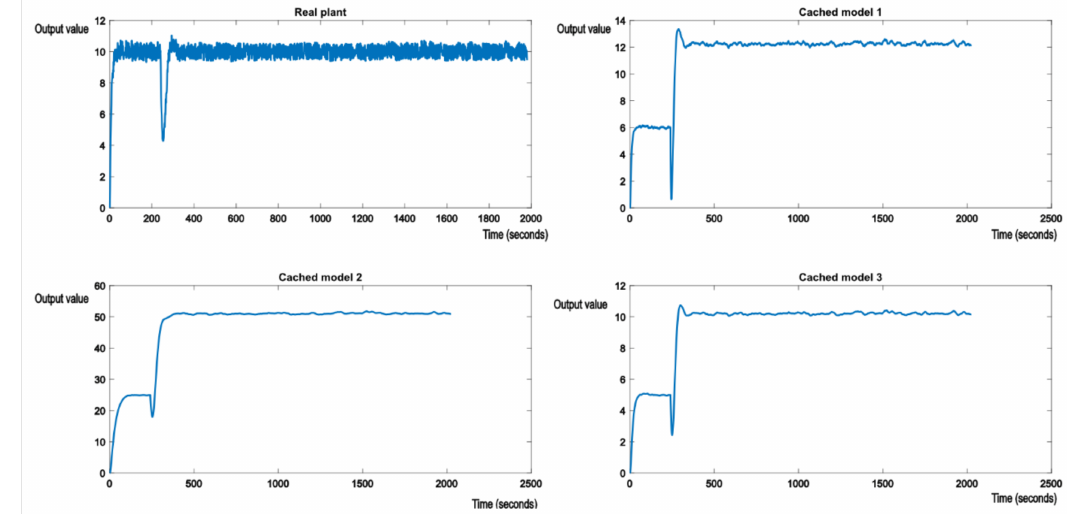
Figure 9. Evolution of the real plant and the nominal models after exposing the real plant to perturbations, with output measurement noise.